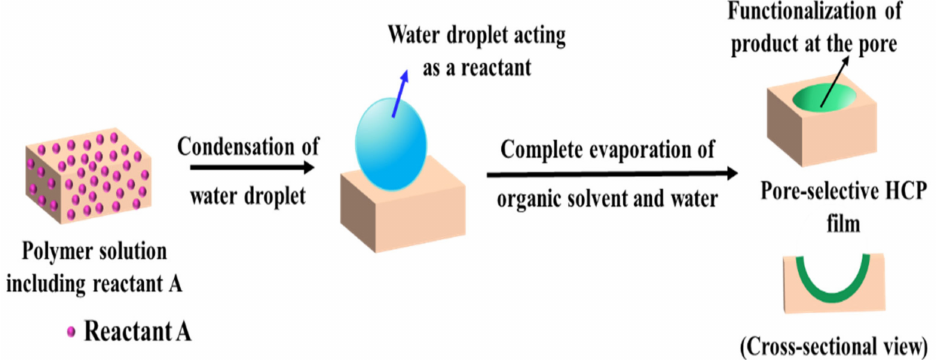
Figure 12. Pore-selective functionalization of HCP films by using water as a reactant. The polymer solution containing a reactant reactive to water is cast under humid conditions for the reaction to occur at the interface of polymer solution/water droplet to achieve pore-selective functionalization.